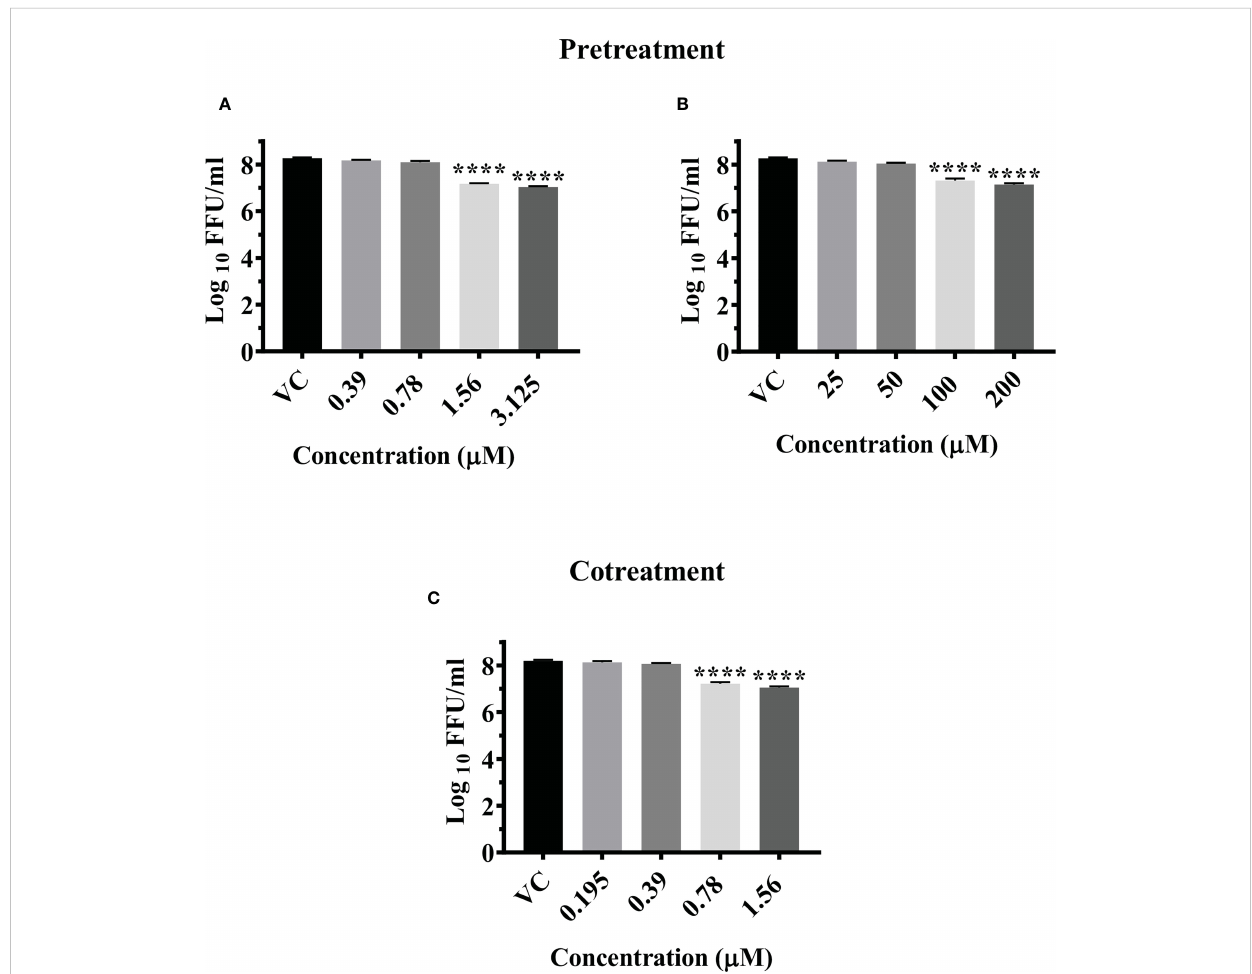
FIGURE 3 Antiviral effect of felbinac (A) , metyrapone (B) under pretreatment condition and Enalaprilat (C) under cotreatment condition against CHIKV. Vero CCL-81 cells were pre and co treated with different concentrations of drug and incubated for 24 hrs. After incubation. culture supernatants were processed for the FFU assay. The trials were carried out in triplicate at two different time points, and the outcomes are expressed as mean log10 focus forming unit/ml ± standard error. All the treatment conditions were compared with the VC. ****